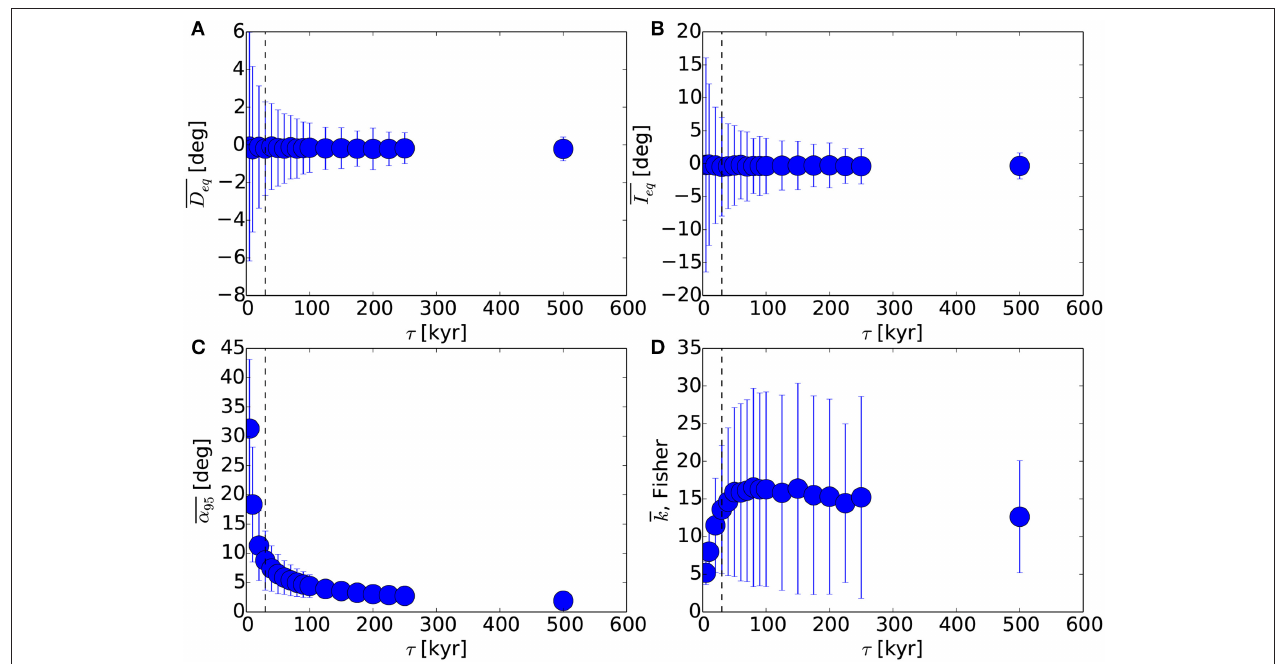
FIGURE 4 | From model 4, mean and standard deviation (error bars) of running means of synthetic observations at the equator for a range of running average lengths τ . (A) Magnetic declination D eq from (8). (B) Magnetic inclination I eq from (9). (C) Angular spread of magnetic pole location at 95% confidence level, α 95 from (10). (D) Fisher’s precision parameter k from